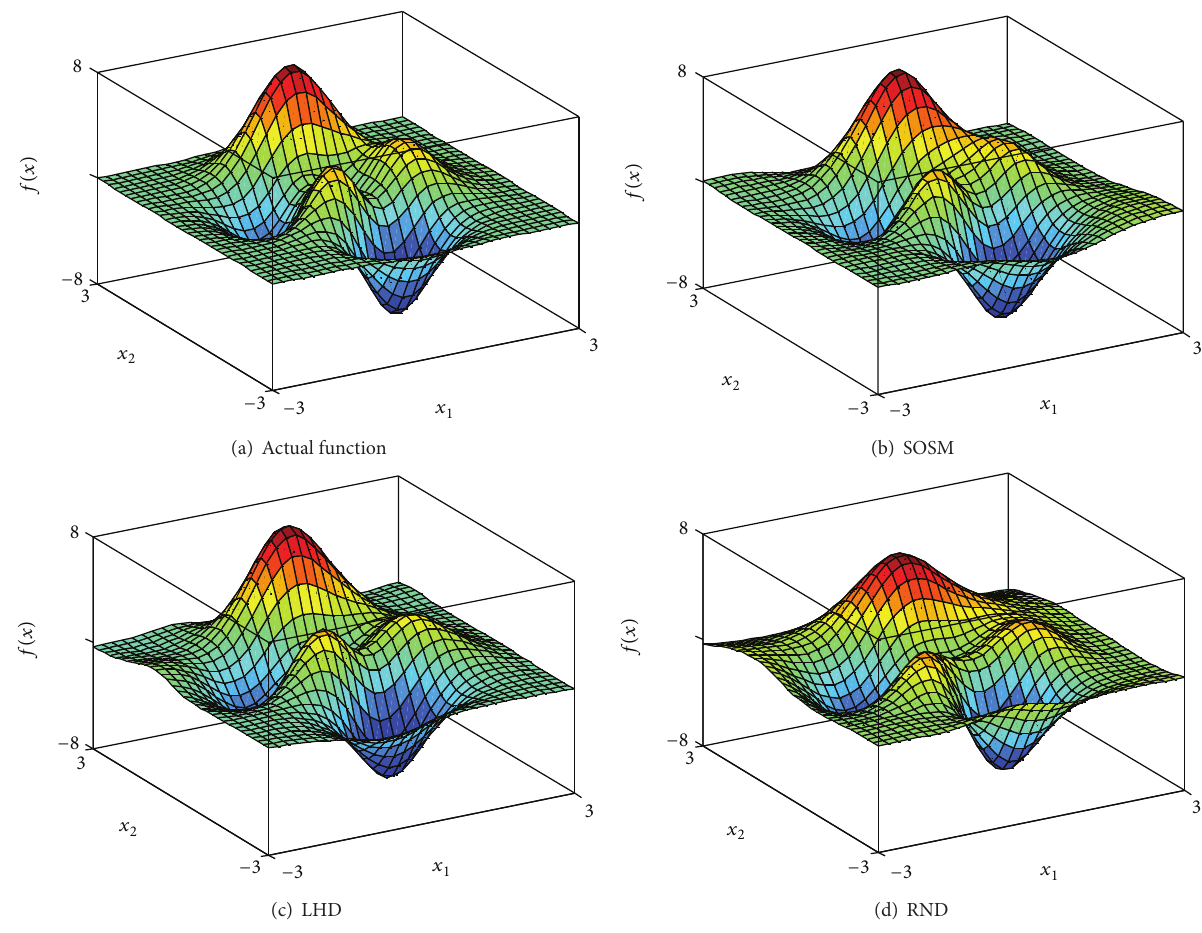
Figure 14: Function 4: actual and metamodel